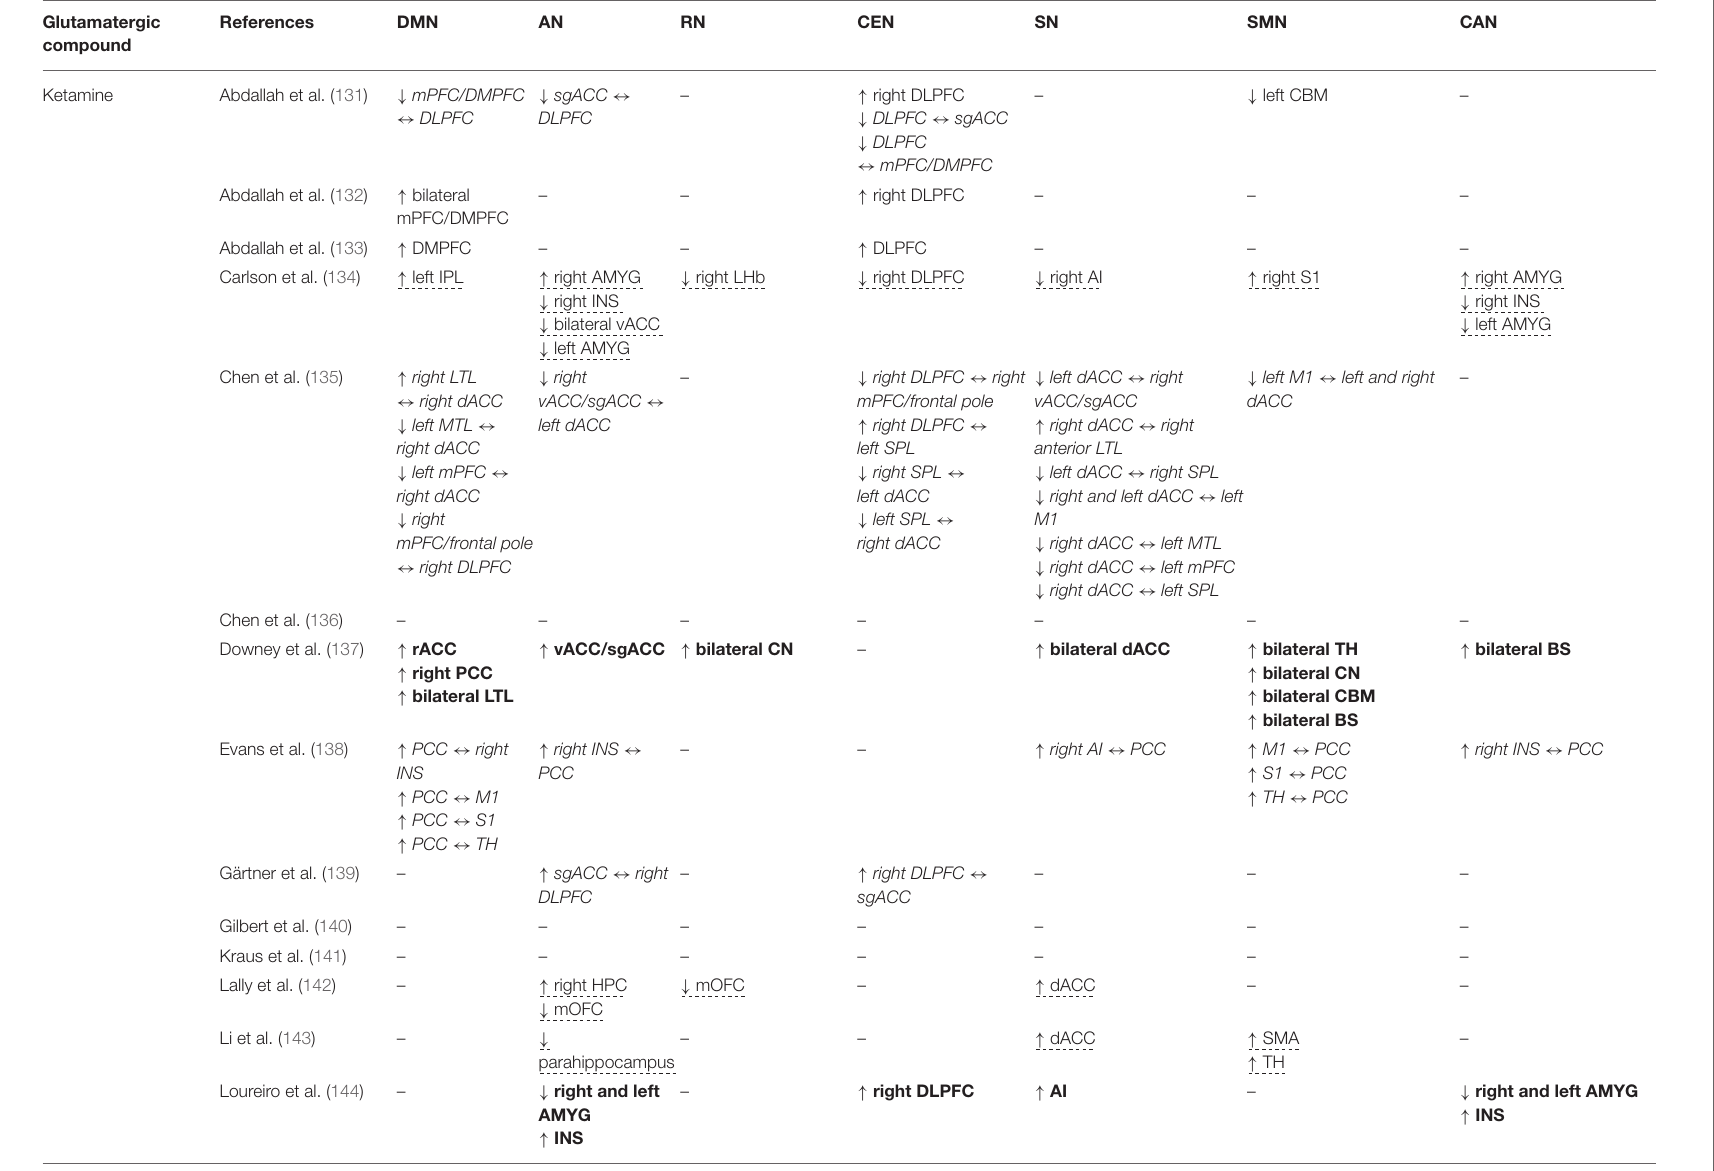
TABLE 4A | Effect of glutamatergic interventions on intrinsic connectivity